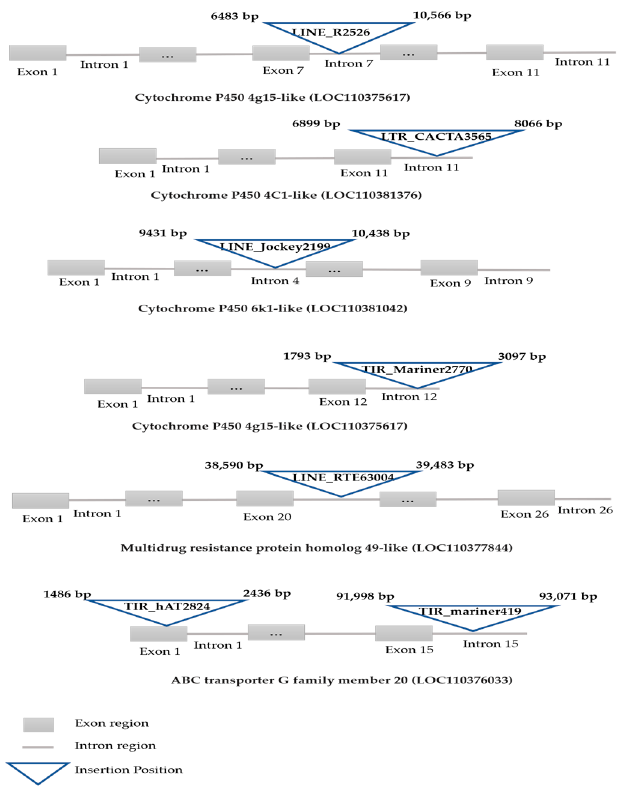
Figure 4. Schematic representation of TE insertion sites in genes encoding for detoxifying enzymes in H. armigera.